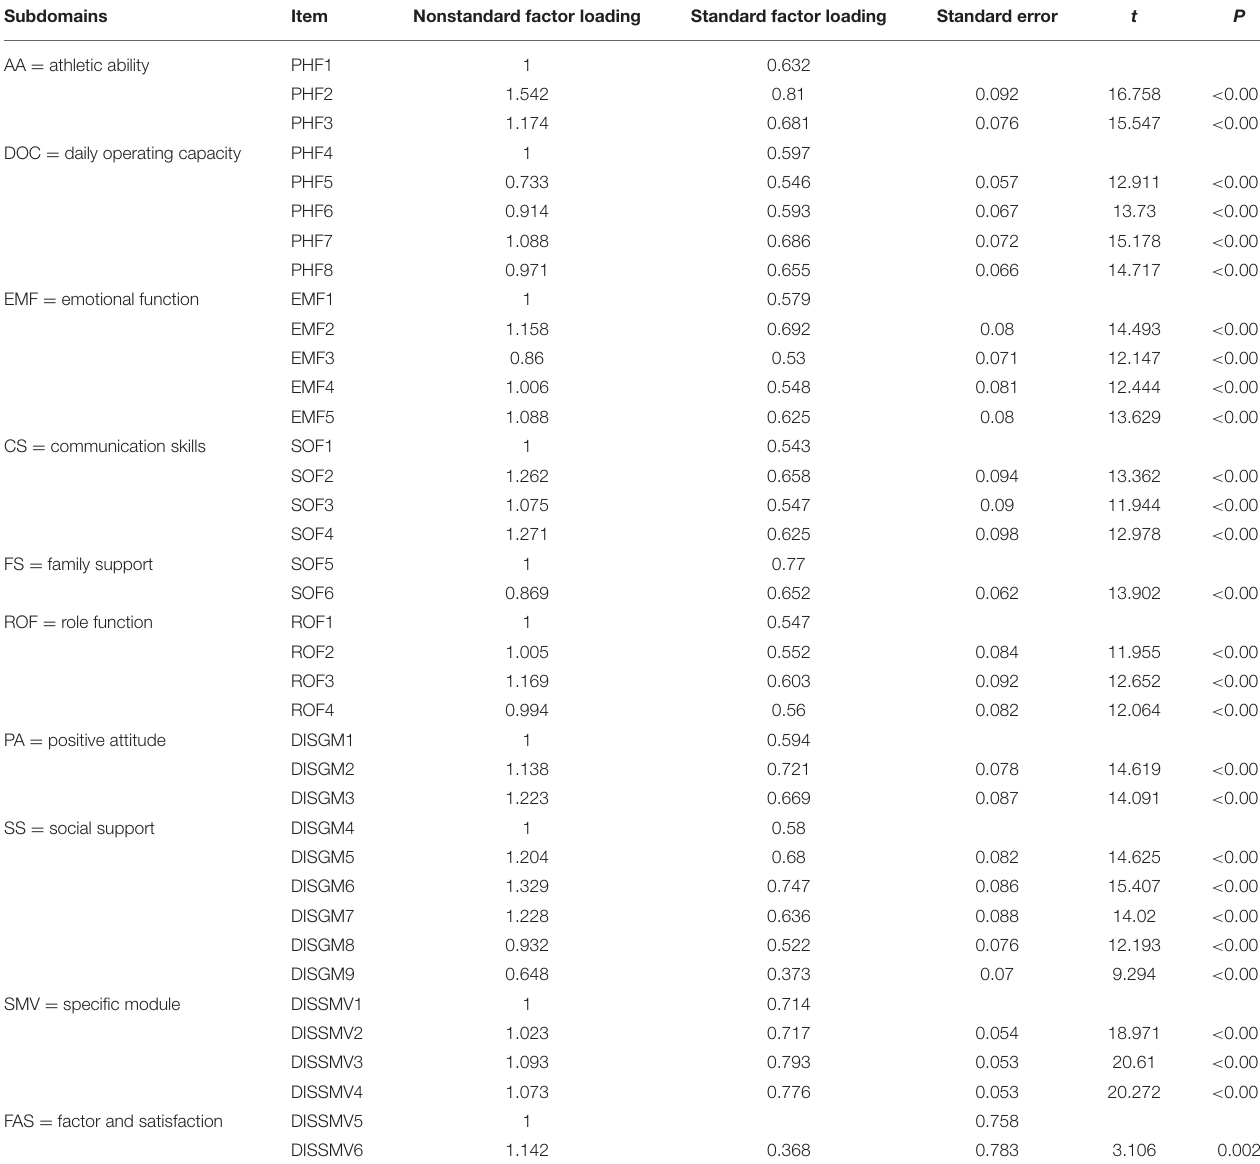
TABLE 5 | Results of the confirmatory factor